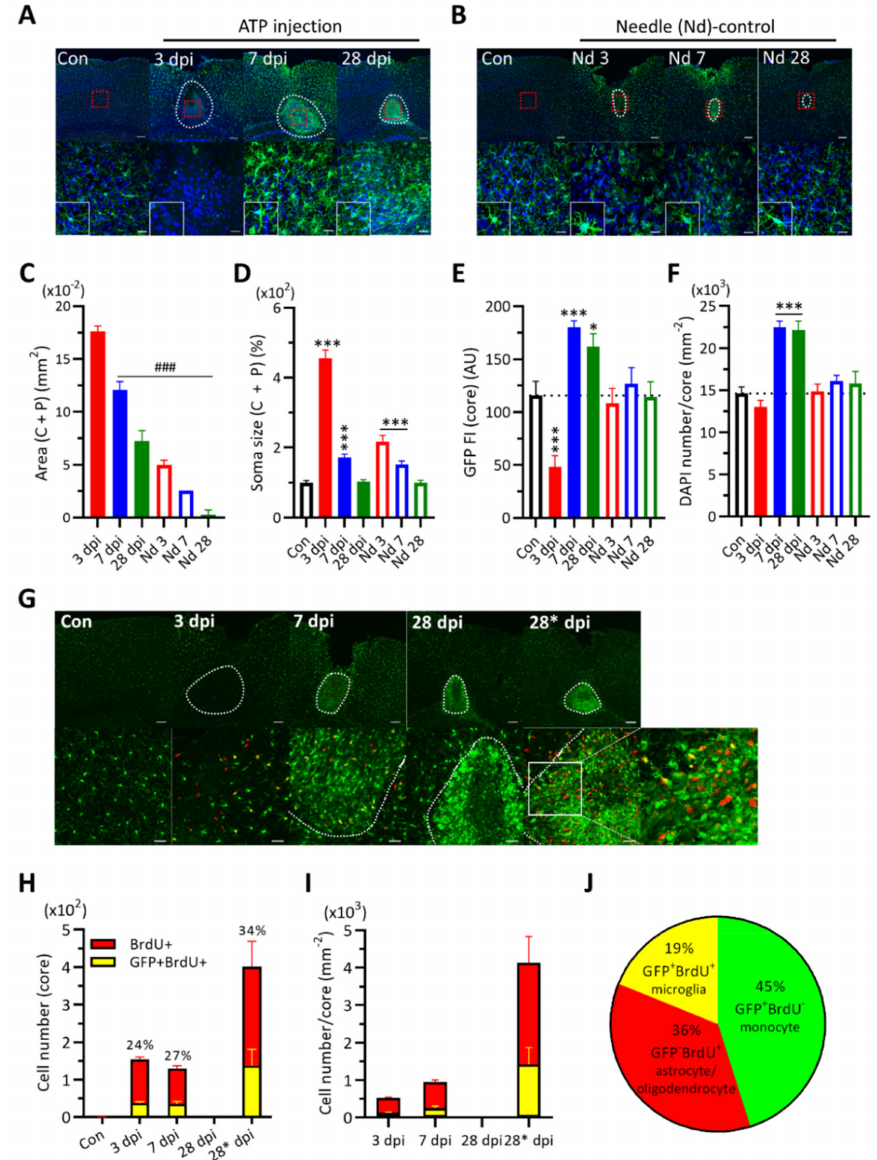
Figure 1. ATP injection causes significant cellular changes compared to needle-control in cortical area. Two-tailed t -test for comparing the experimental group to the control group (*) or to the 3 dpi group (#) (*, # for p < 0.05; **, ## for p < 0.01; ***, ### for p < 0.001). ( A ). Upper : Representative images of CX 3 CR1-GFP expression in cortical tissues from ATP injected mice (Control, 3rd, 7th, 28th dpi). DAPI in blue. White dotted line indicates the damaged area (core + penumbra); red square indicates the area for high magnification image below. Lower : high magnification images. Scale bars , 100 µ m ( upper ) and 20 µ m ( lower ). Inset , representative image of CX 3 CR1-GFP (+) cells in the core. ( B ). Needle (Nd)-control cortical tissue data (Control, Nd 3rd, Nd 7th, Nd 28th dpi). Same as in ( A ). ( C ). Measurement of damaged areas by ImageJ. Two-tailed t -test. Open bars indicate naïve or needle-control tissue data and filled bars indicate ATP-injected tissue data ( C – F ). ( D ). Soma size of CX 3 CR1-GFP (+) cells in damaged areas. Two-tailed t -test. ( E ). GFP fluorescence intensity measurement per core area. Two-tailed t -test. ( F ). DAPI (+) cell density in the core. Two-tailed t -test. ( G ). Upper : Representative images showing BrdU (+) cells (red) in the damaged area after ATP injection. Con, 3 dpi, 7 dpi, 28 dpi for BrdU injection once; 28* dpi for BrdU 8 × injection. White dotted line indicates the core area for analysis. Lower : Magnified images. Scale bars , 100 µ m (upper) and 20 µ m (lower). Far right is the expanded image of the square region (white line). ( H ). The number of BrdU (+) cells in the core and the portion (%) of GFP (+) BrdU (+) cells among BrdU (+) cells. ( I ). The densities of BrdU (+) cells (in red) and BrdU (+) GFP (+) cells (in yellow) in the core. ( J ). The pie graph of the estimated portion of population of each cell types in the core area at 28*